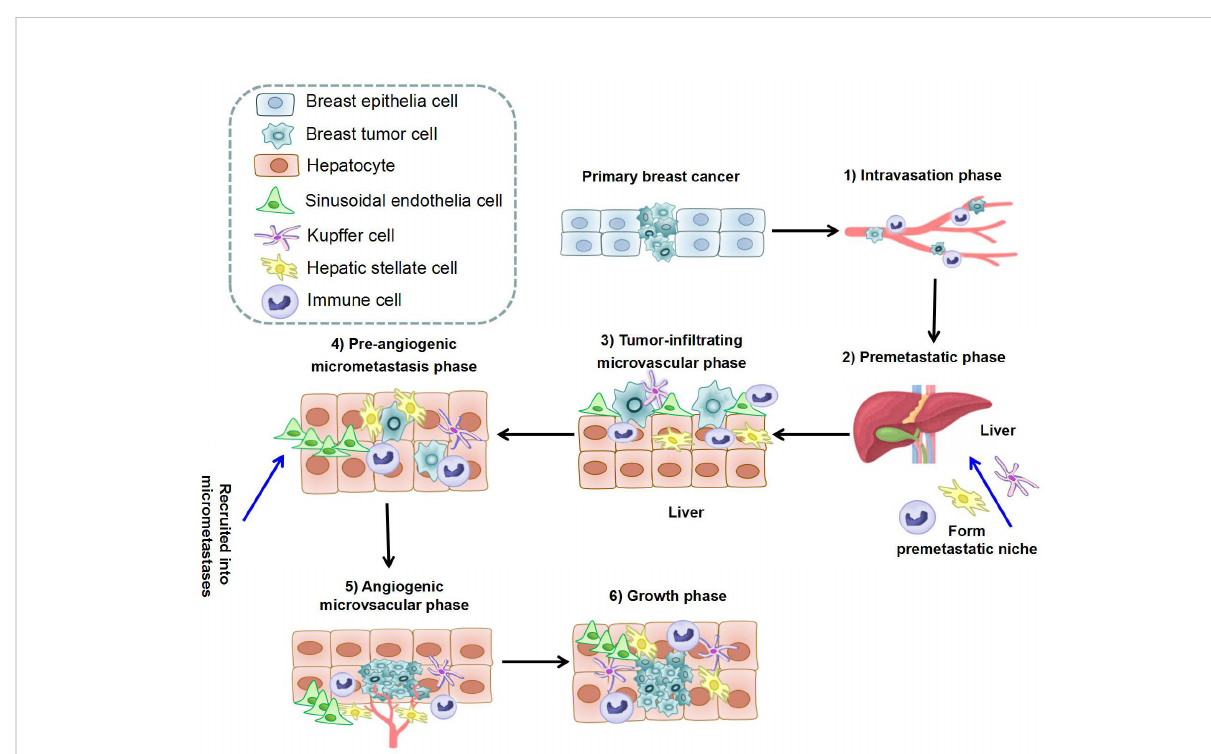
FIGURE 1 The process of liver metastasis formation in breast cancer. The whole process can be separated into six steps: 1) Intravasation phase: cancer cells intravasate into the circulation system under help of immune cells; 2) Premetastatic phase: HSCs, KCs, and immune cells in hepatic microenvironment form premetastatic niche; 3) Tumor-in fi ltrating microvascular phase: cancer cells extravasate into liver parenchyma through LSECs; 4) Pre-angiogenic micrometastatic phase: HSCs and immune cells are recruited into micrometastases and activate local stromal response; 5) Angiogenic micrometastatic phase: micrometastases become vascularized and interact with cells in the microenvironment; 6) Growth phase: metastases expansion under the stimulation of hepatocytes, HSCs, and immune cells. (HSC, Hepatic stellate cell; KC, Kupffer cell; LSEC, Liver sinusoidal endothelial cells).